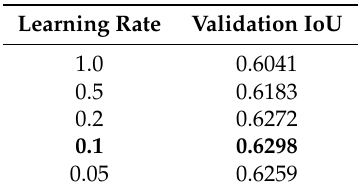
Table 1. Results for GeoBoost with different learning rates.